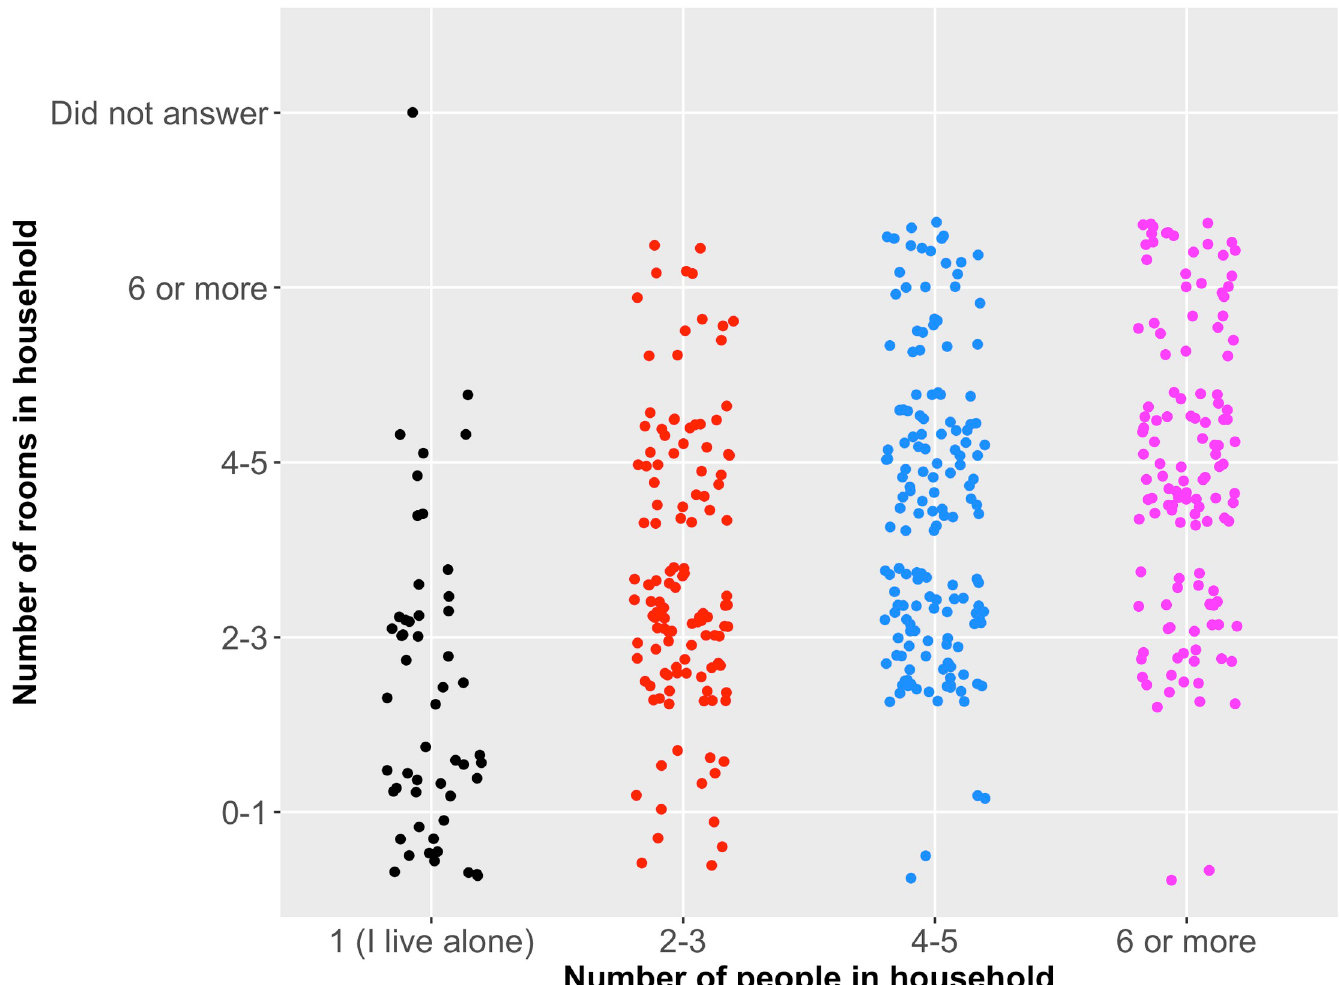
Fig 5. Association between household size and number of rooms in